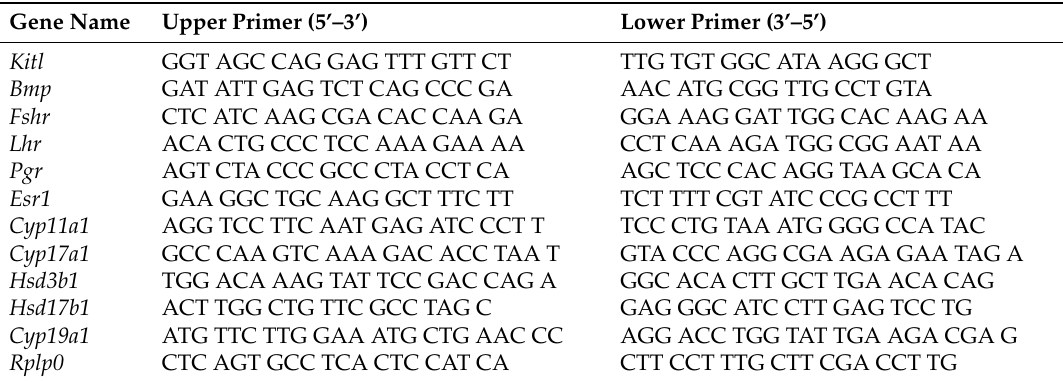
Table 1. Primers used for real-time or conventional